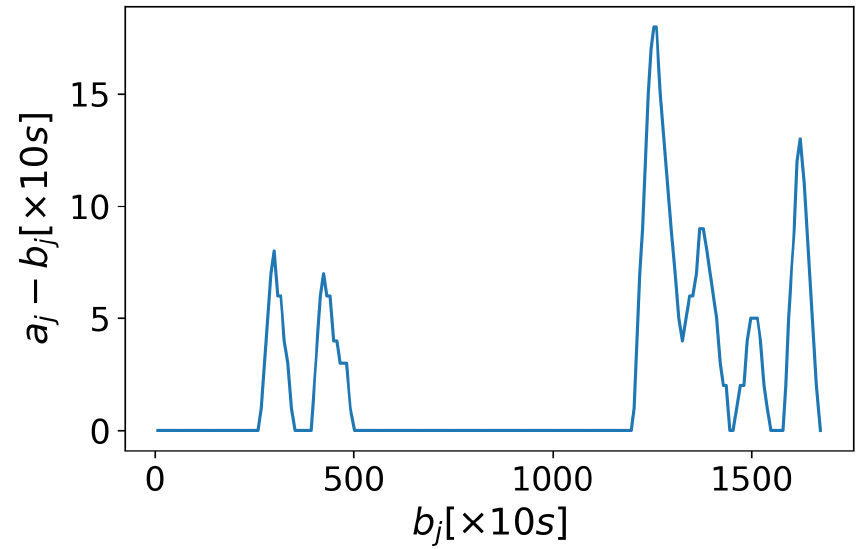
Figure 12. Adjustment of arrival time for each aircraft (Scenario